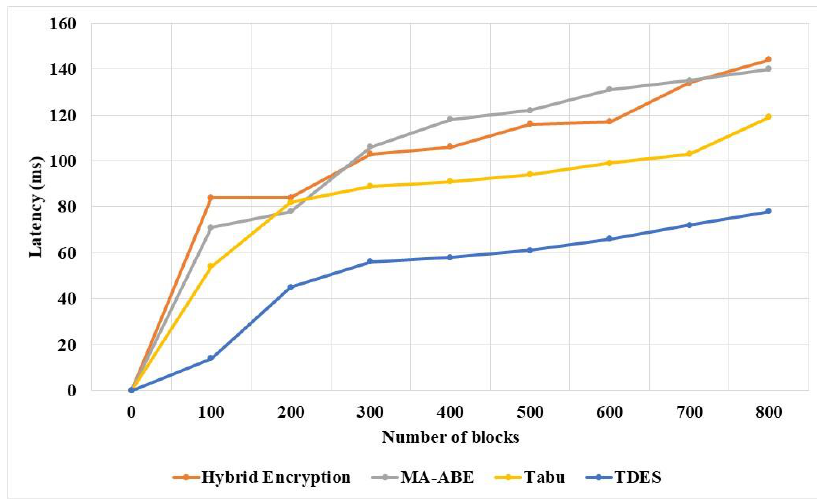
Figure 10. Comparing TDES and existing techniques’ latency for various numbers of blocks.